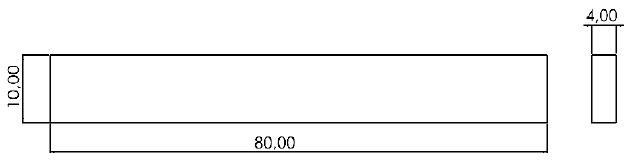
Figure 5. DIN EN ISO 75 sample dimensions.